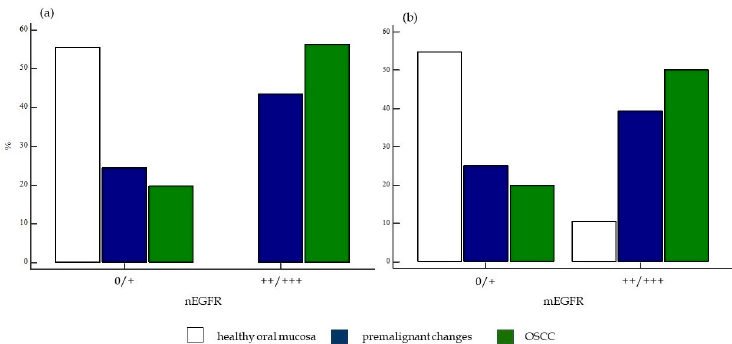
Figure 12. Presentation of the difference between weak and strong expression of nEGFR and mEGFR between the studied groups of subjects. Comparison of weak and strong expression of ( a ) nEGFR and ( b ) mEGFR between the analyzed groups of subjects revealed statistical signi fi cance ( χ 2 = 49.85, p < 0.0001; χ 2 = 34.05, p < 0.0001). Legend: nEGFR—nuclear EGFR; mEGFR—membrane EGFR; 0—negative and weak expression, 1—moderate and strong expression. 2.1.6. Correlation of nEGFR Expression with mEGFR and Markers of Cell Cycle, Cell Proliferation, and Tumor Stem Cells in Healthy Oral Mucosa, Premalignant Changes, and Invasive Oral Squamous Cell Carcinoma In the group of healthy subjects, the correlation of expression between the tested markers did not show statistically signi fi cant results, which are therefore not shown. In the group of patients with premalignant changes, a statistically signi fi cant positive correlation was observed between nEGFR and Ki-67 ( ρ = 0.45, p = 0.001), p53 ( ρ = 0,50, p = 0.0002), cyclin D1 ( ρ = 0.42, p = 0.002), mEGFR ( ρ = 0.54, p < 0.0001) and ABCG2 ( ρ = 0.42, p = 0.002). A statistically signi fi cant correlation was observed between mEGFR and Ki-67 ( ρ = 0.51, p = 0.0002), p53 ( ρ = 0.50, p = 0.0002), nEGFR ( ρ = 0.54, p < 0.0001), cyclin D1 ( ρ = 0.38, p = 0.005), and ABCG2 ( ρ = 0.49, p = 0.0003). In the group of patients with premalignant changes, a statistically signi fi cant positive correlation between the degree of dysplasia and nEGFR ( ρ = 0.60, p < 0.0001), Ki-67 ( ρ = 0.42, p = 0.002), p53 ( ρ = 0.50, p = 0.0002), cyclin D1 ( ρ = 0.35, p = 0.01), mEGFR ( ρ = 0.53, p = 0.0001) was also detected, while ABCG2 showed no signi fi cant correlation ( ρ = 0.24, p = 0.10). Considering the association of nEGFR with cell analyzed markers in the OSCC group, a statistically signi fi cant positive correlation was observed between nEGFR and Ki- 67 ( ρ = 0.31, p = 0.002), p53 ( ρ = 0.30, p = 0.03), and mEGFR ( ρ = 0.31, p = 0.02), while the correlation with cyclin D1 ( ρ = 0.20, p = 0.16) and ABCG2 ( ρ = 0.21, p = 0.12) was not ob- served. A statistically signi fi cant correlation was observed between mEGFR and Ki-67 ( ρ = 0.34, p = 0.01), p53 ( ρ = 0.37, p = 0.006), and nEGFR ( ρ = 0.31, p = 0.02), while the correlation with cyclin D1 ( ρ = 0.07, p = 0.62) and ABCG2 ( ρ = − 0.18, p = 0.19) was not observed.